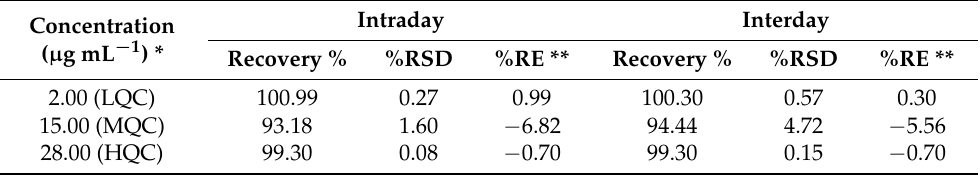
Table 2. Intra and inter assay precision and accuracy of the proposed method. Concentration